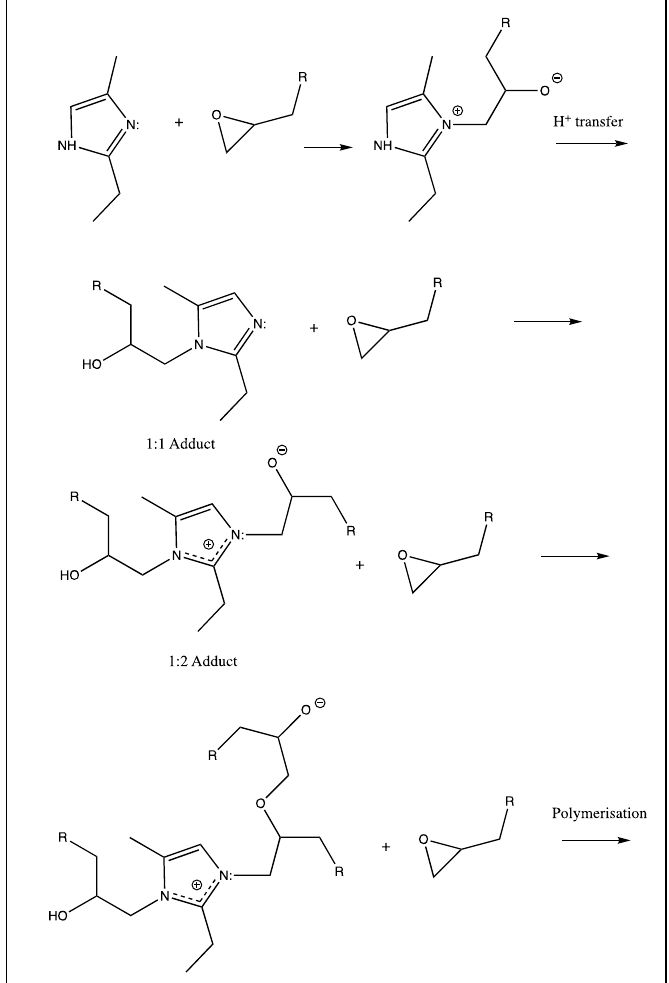
Figure 1. Mechanism of the reaction between 2-ethyl-4(5)-methylimidazole and phenyl glycidyl ether (PGE), as proposed by Barton and Shepherd (R = OPh) [20].